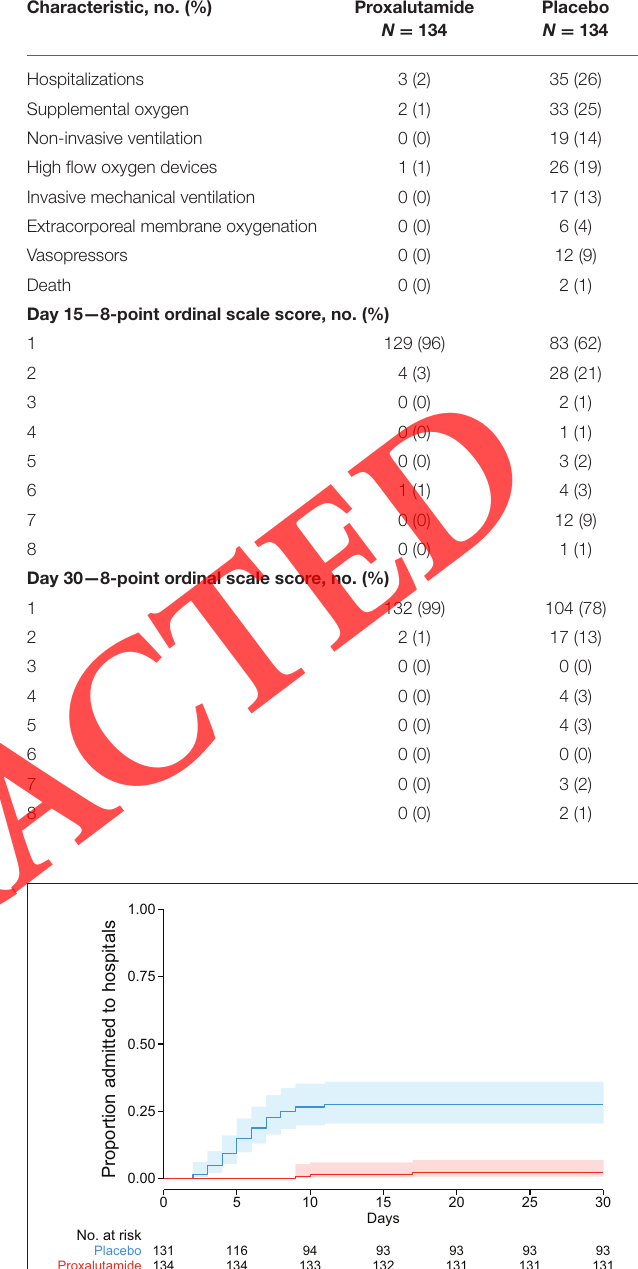
FIGURE 2 | Kaplan-Meier estimates of proportion admitted to hospitals due to COVID-19 during the 30-day post-randomization